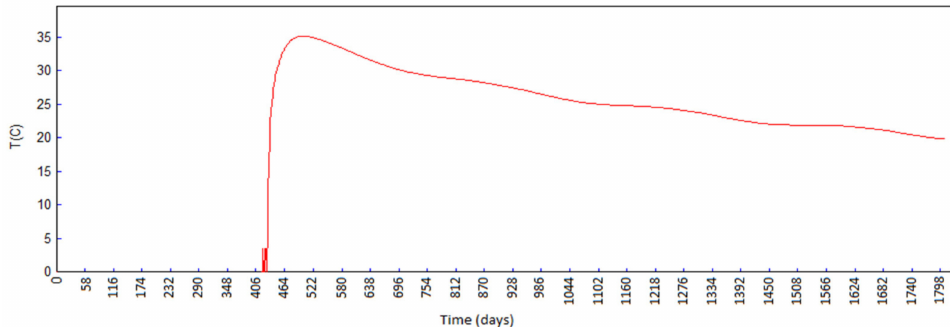
Figure 11. Concrete temperature ( ◦ C) in node 3016 (middle of the monolith).